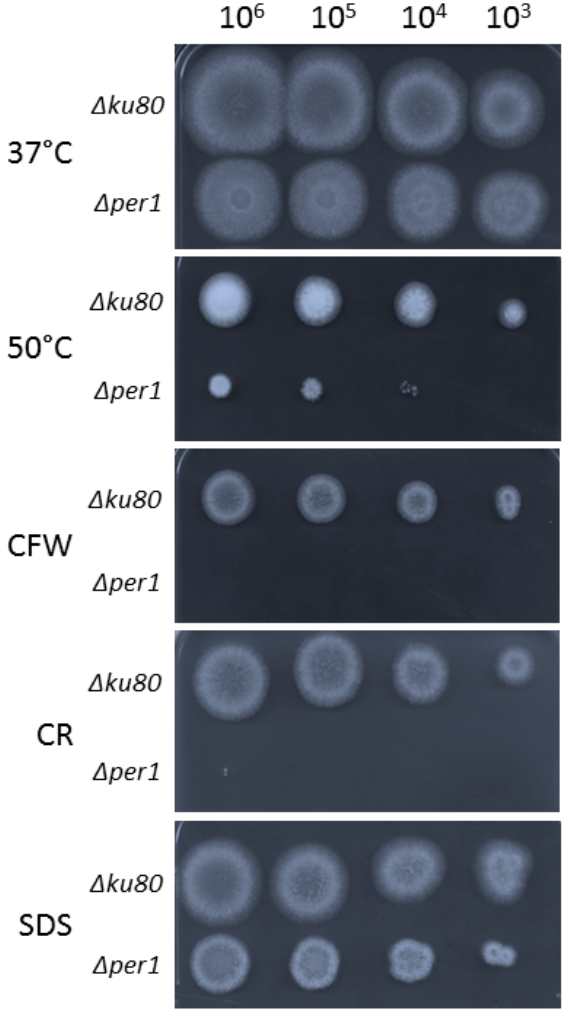
Figure 2. Growth of PER1 deletion mutant strain on solid medium. Radial growth of the parental strain and PER1 deletion mutant strain on malt agar medium (48–72 h at 37 °C or 50 °C) with or without calcofluor white (CFW, 40 μ g/mL), Congo red (CR, 50 μ g/mL), SDS (0.01%).